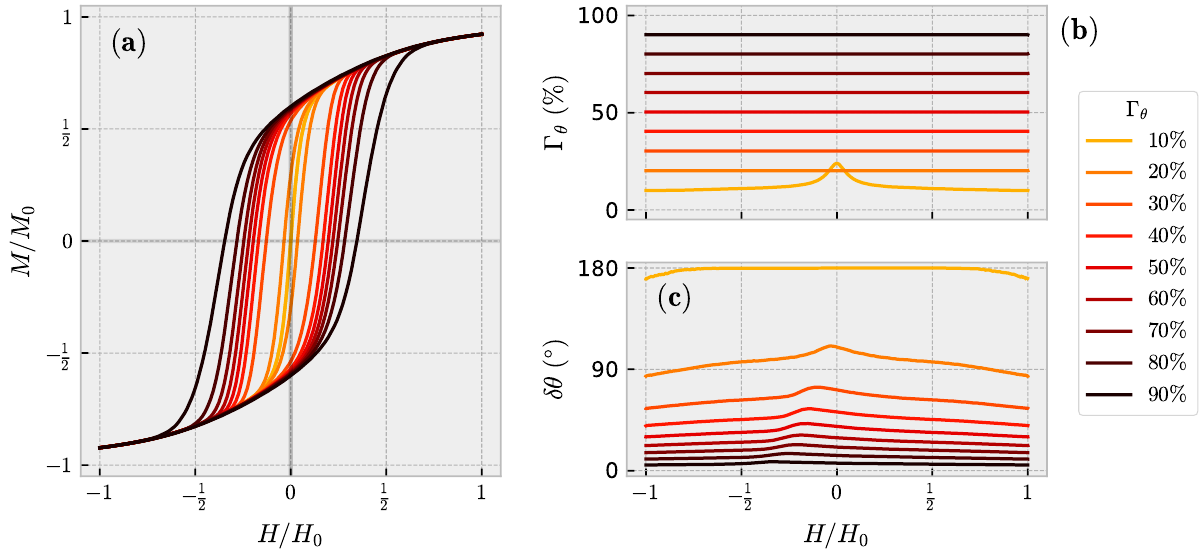
Figure 4. Reduced magnetization ( a ), acceptance rate ( b ) and cone aperture ( c ) as a function of the external magnetic